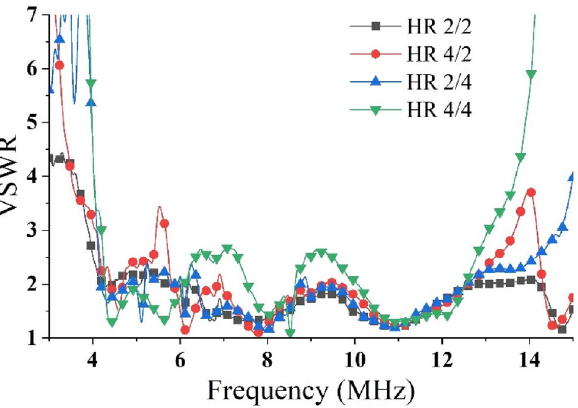
Figure 11. Feeding network participation, the VSWR of the total port in each mode.